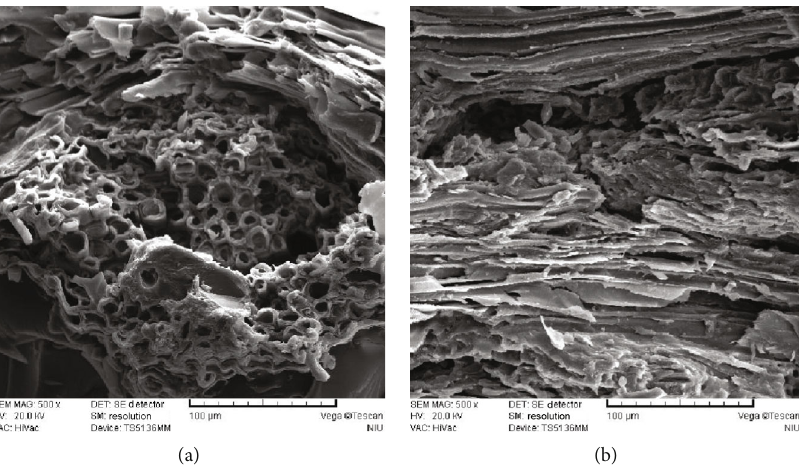
Figure 14: SEM graph of PU(PPG 700)-EP graft-IPNs added unmodi fi ed sugarcane bagasse (500x), bioadditive content: (a) 30 wt%; (b) 50wt%.